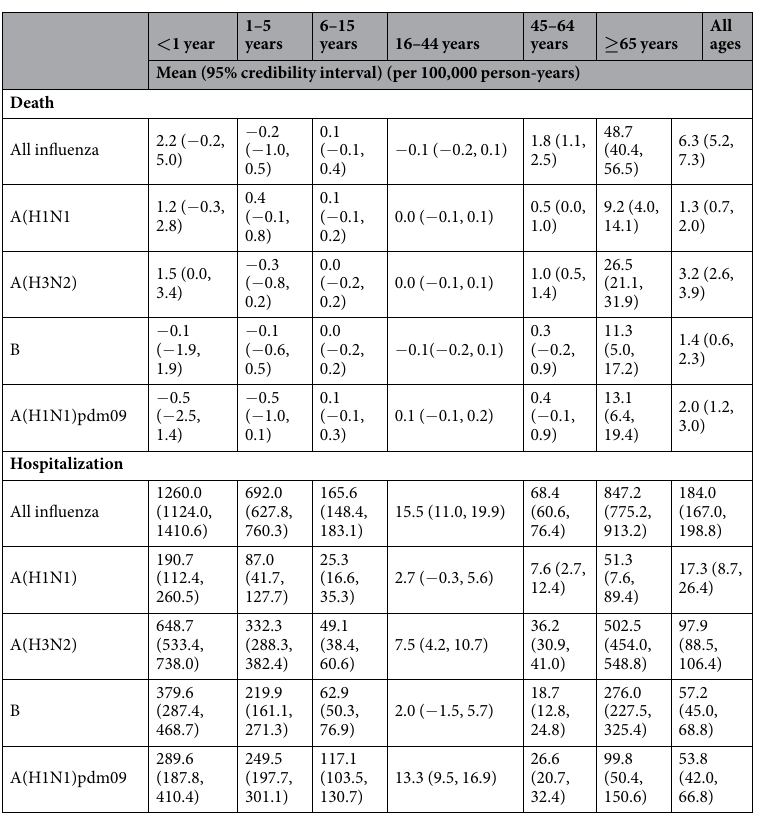
Table 1. Average annual influenza-associated excess mortality and hospitalization rates from respiratory diseases by type and subtype of virus in different age groups of Hong Kong population from January 1998 through June